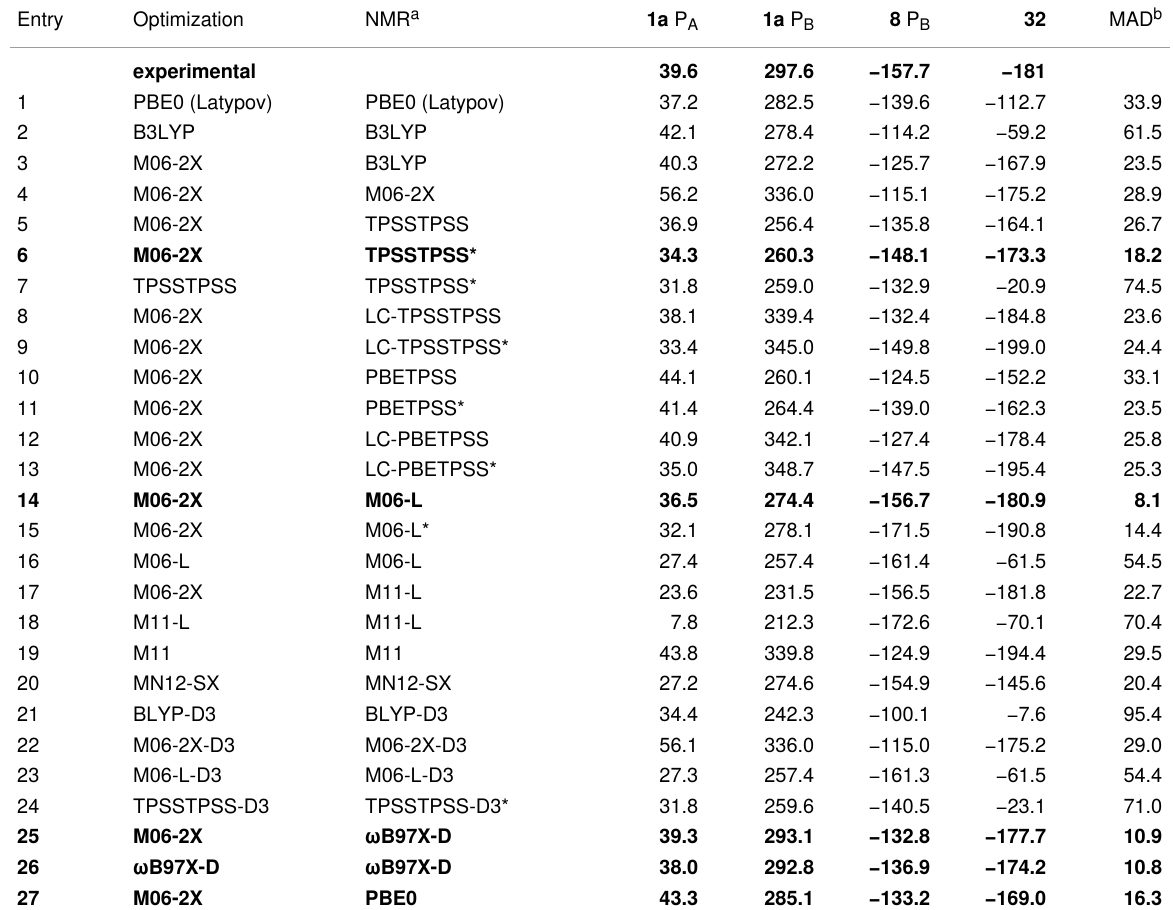
Table 4: Scaled (using PH 3 and PCl 3 ) chemical shifts for the “failures” 1a , 8 , and 32 for various optimization and NMR